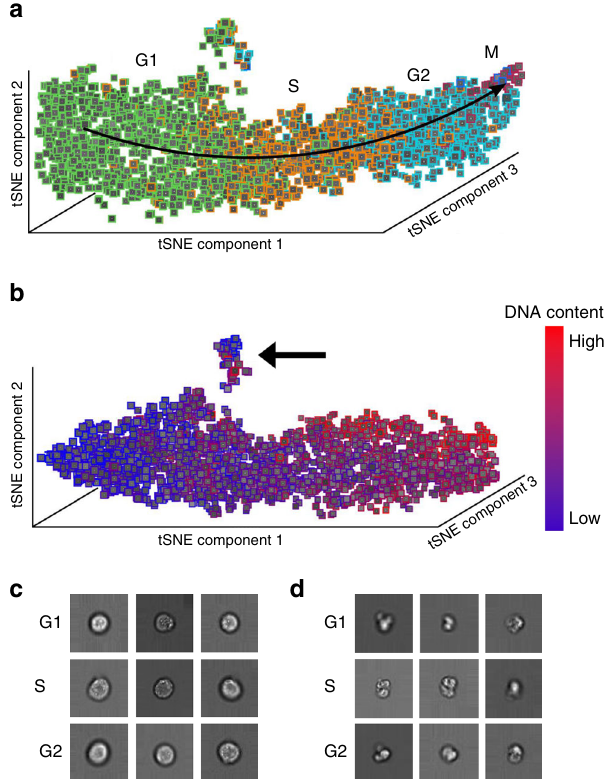
Fig. 3 Cell-cycle reconstruction and detection of abnormal cells. a tSNE visualization of the validation data set in activation space representation. All interphase classes (G1, S, G2) and the two mitotic phases with the highest number of representatives are shown (Prophase: red , Metaphase: blue ). Telophase and Anaphase are not visible due to their low number representatives. b tSNE visualization of data from the interphase classes (G1, S, G2) in activation space. The color map now shows the DNA content of cells. A cluster of damaged cells is indicated with an arrow. c Randomly picked representatives from the bulk of undamaged cells. d Randomly picked representatives from the cluster of damaged